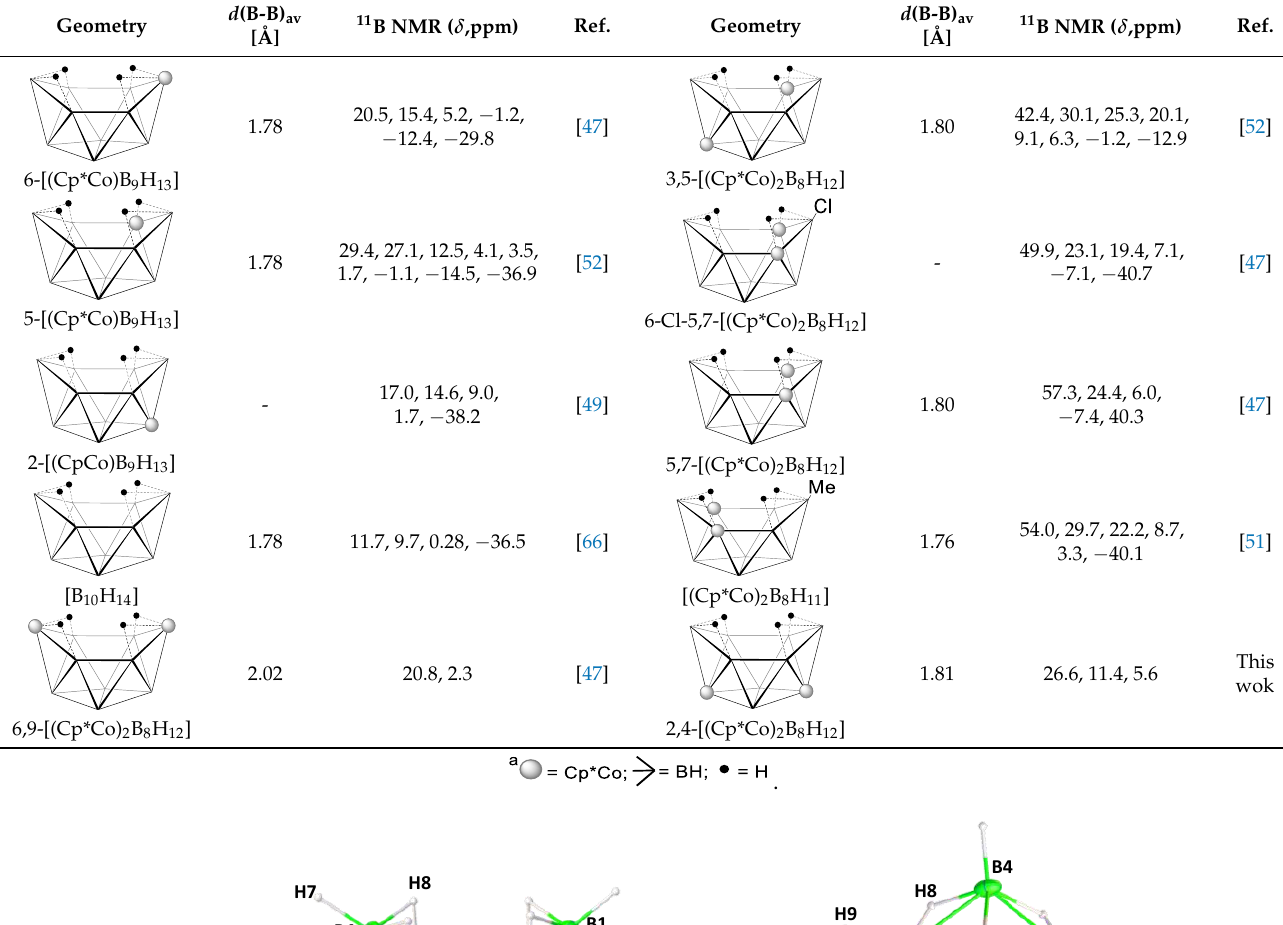
3 on model 2′ (Cp analogue of 2 ) as well as on its group-9 metallaborane model analogues